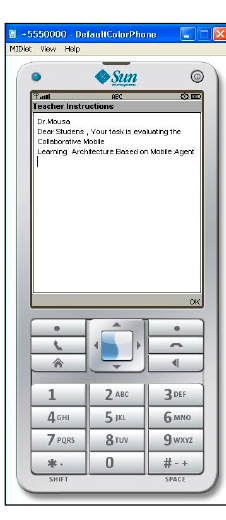
Figure 13. Mobile learning GUI — the learner agent shows learner output interactions, learner’s name, and input interactions.